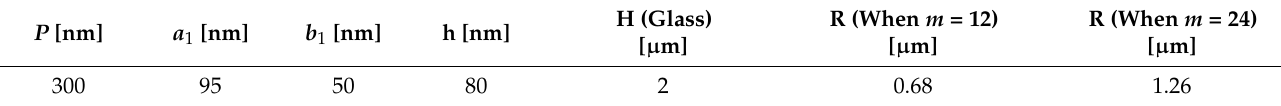
Figure 1. ( a ) The LCP light passes through the metasurface of single-layer metal nanoholes and generates OVs based on SOI. ( b ) Schematic of single elliptical nanohole structure. ( c ) Left: transmis- sion spectra affected by the change in the short axis radius of single elliptical nanohole. Right: the efficiency of transmitted light carrying additional phase at different wavelengths. ( d , e ) The resonance electric field |E| generated by the incidence of 632 nm LCP and RCP light, respectively. Table 1. Geometric parameters of the